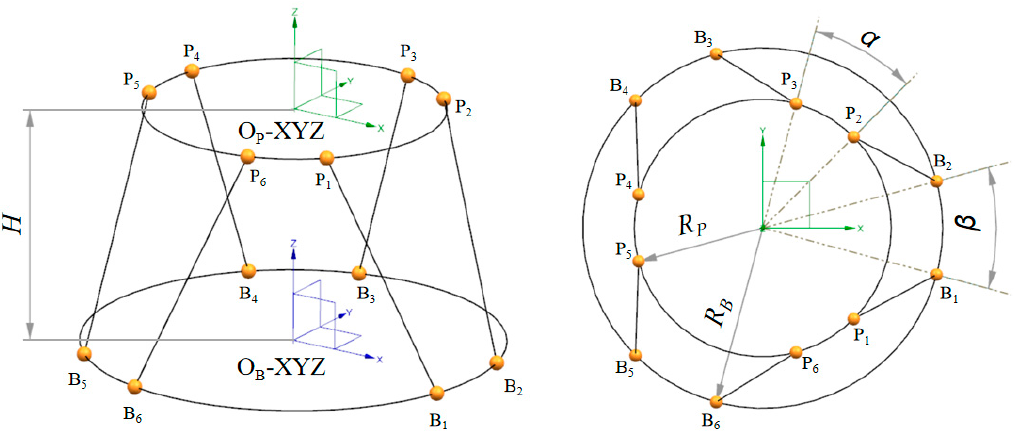
Figure 1. Schematic diagram of Stewart Platform.